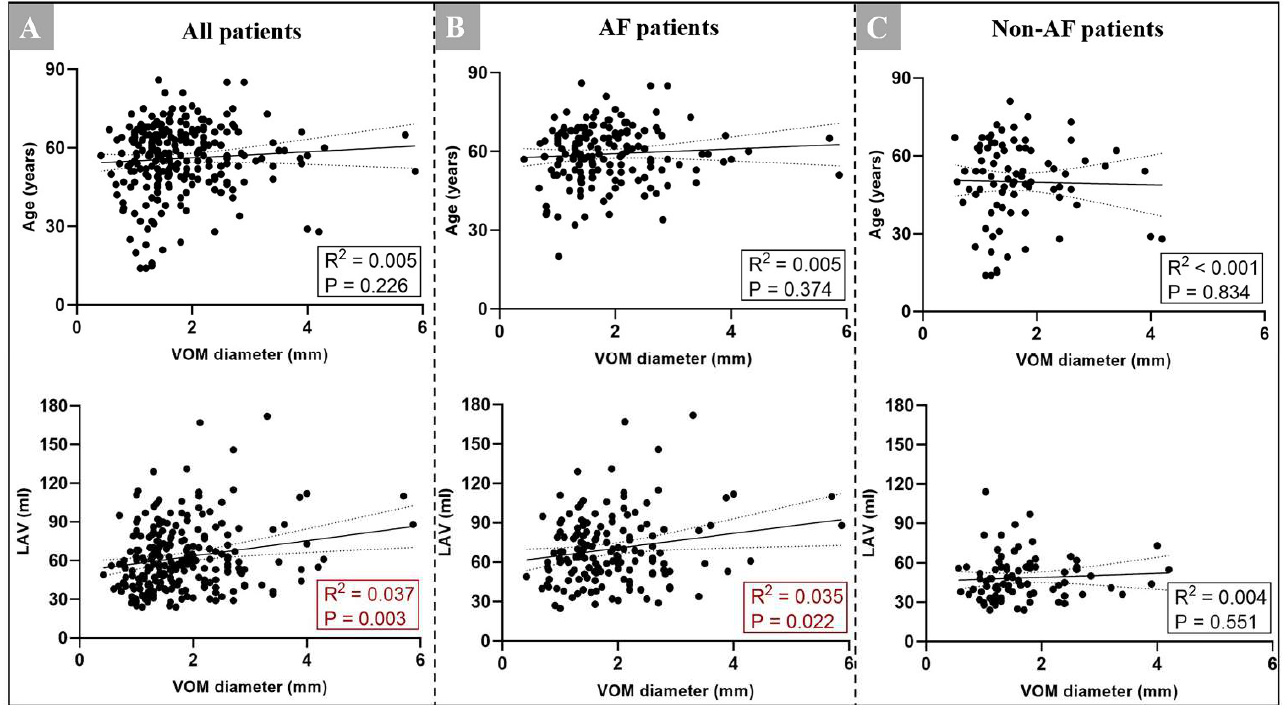
Figure 4. ( A ) Correlation between the VOM ostium diameter and age as well as LAV in all patients (n = 290); ( B ) correlation between the VOM ostium diameter and age as well as LAV in AF patients (n = 183); ( C ) correlation between the VOM diameter and age as well as LAV in non-AF patients (n = 107). AF = atrial fibrillation; CS = coronary sinus; CSo = coronary sinus ostium; LAV = left atrial volume; VOM = vein of Marshall.